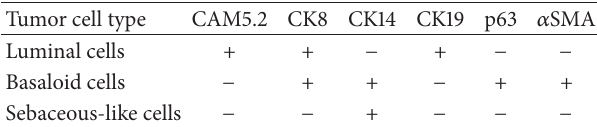
Figure 2: Sebaceous differentiation observed within the apocrine ductal adenoma. Sebaceous cells are characterized by abundant, clear, and vacuolated cytoplasm and a centrally located nucleus surrounded by basaloid cells in the apocrine ductal adenoma. HE. Bar = 50 𝜇 m. Inset: a frozen section stained with oil red O revealing the lipid droplets within the cytoplasm of sebaceous cells. Table 1: Summary of immunohistochemical